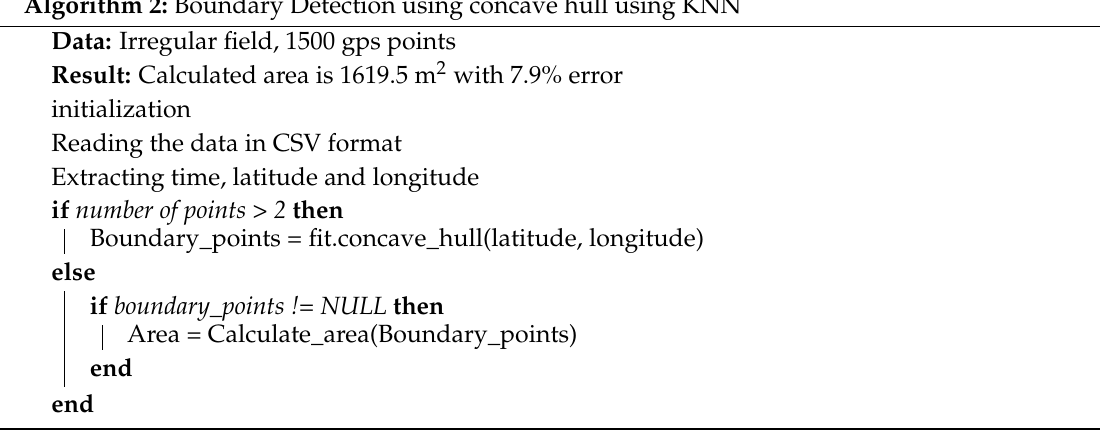
Algorithm 2: Boundary Detection using concave hull using KNN Data: Irregular field, 1500 gps points